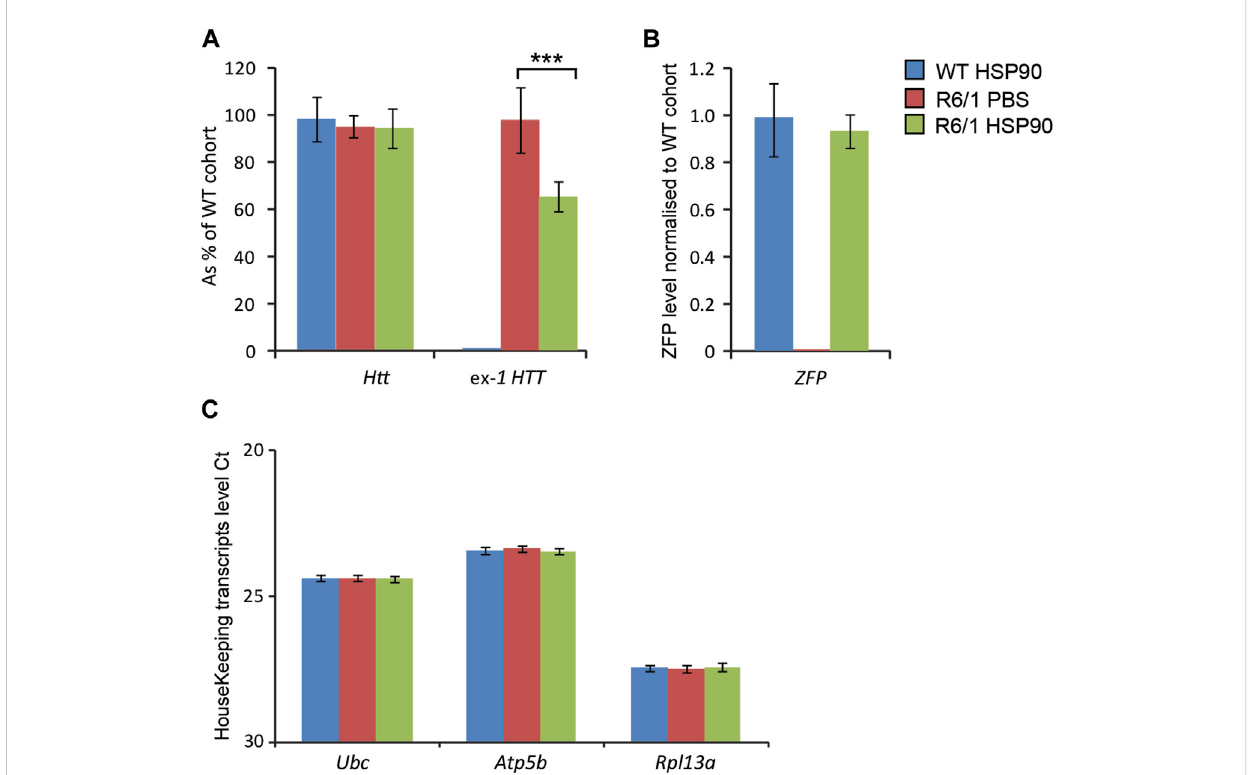
FIGURE 4 Effects of intrathecal injection of AAV expressing mZF-KRAB under the HSP90 promoter. Three month old wild-type and R6/1 mice were treated either with PBS or with AAV2/9 carrying mZF-KRAB under the HSP90 promoter. (A) Unchanged expression WT HTT transcripts as well the repression of mutant Huntingtin mut-Exon1 by the zinc fi nger (ZFP) expression. mZF-KRAB transcript levels are from whole brains of the WT and R6/1 mice. (B) mZF- KRAB transcript levels in the whole brain of wild-type and R6/1 mice. All transcript levels were normalized to three housekeeping genes: (C) Raw crossing threshold (Ct) data for a panel of housekeeping genes. The following gene transcripts were used: Ubc (Ubiquitin C, 22190), Atp5b (ATP synthase subunit, 11947) and Rpl13a (Ribosomal protein L13a, 22121). Error bars are ±SEM ( n = 6). ** p < 0.01, *** p <